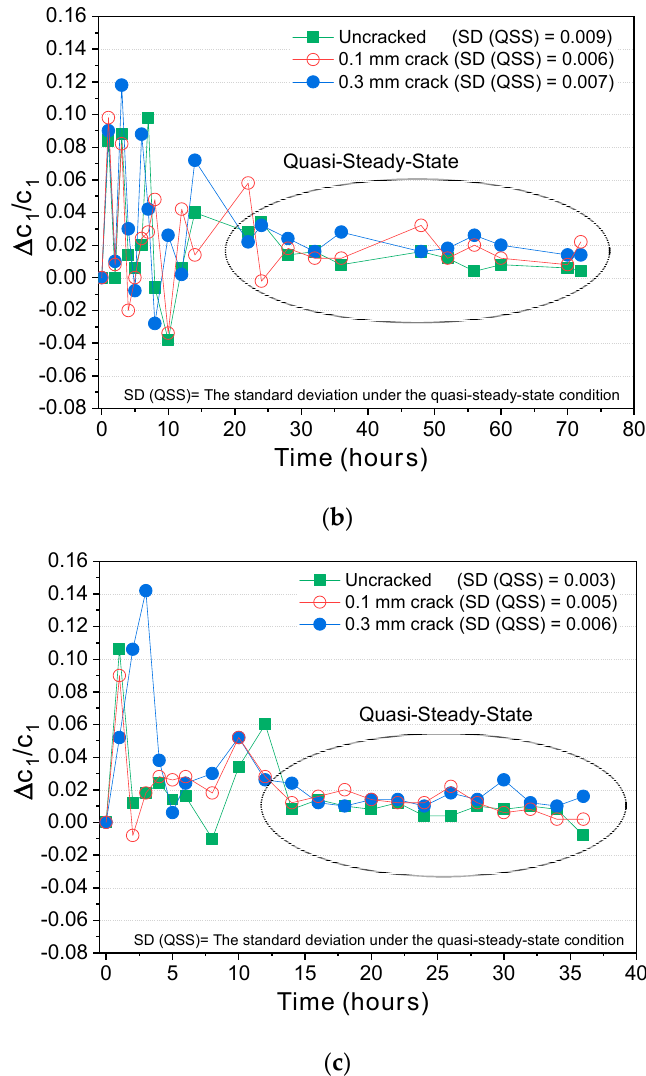
Figure 5. Variation in the rate of chloride concentration drops ( ∆ c 1 / c 1 ) over time: ( a ) 12 V; ( b ) 24 V; ( c ) 36 V.